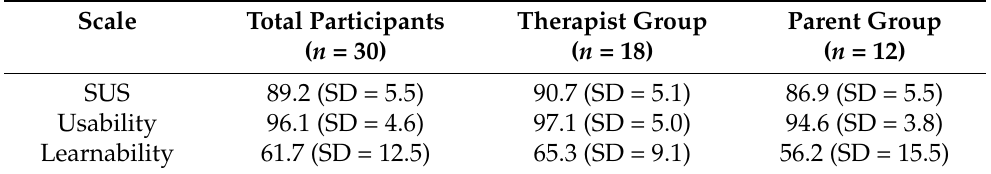
Table 5. Summary of SUS scores. The table reports the mean and standard deviations of SUS, usability, and learnability scores, both general and specific, for the two user